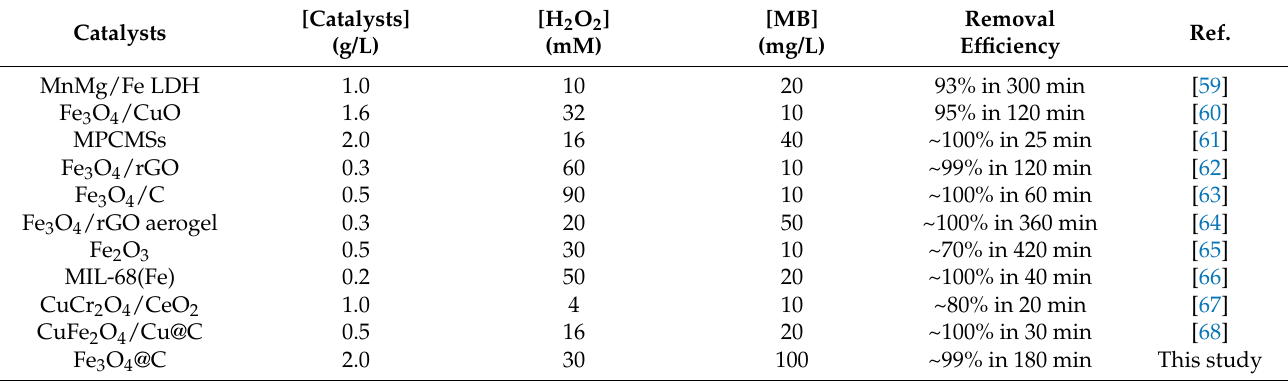
Table 4. The comparison of different catalysts for MB degradation through the Fenton-like